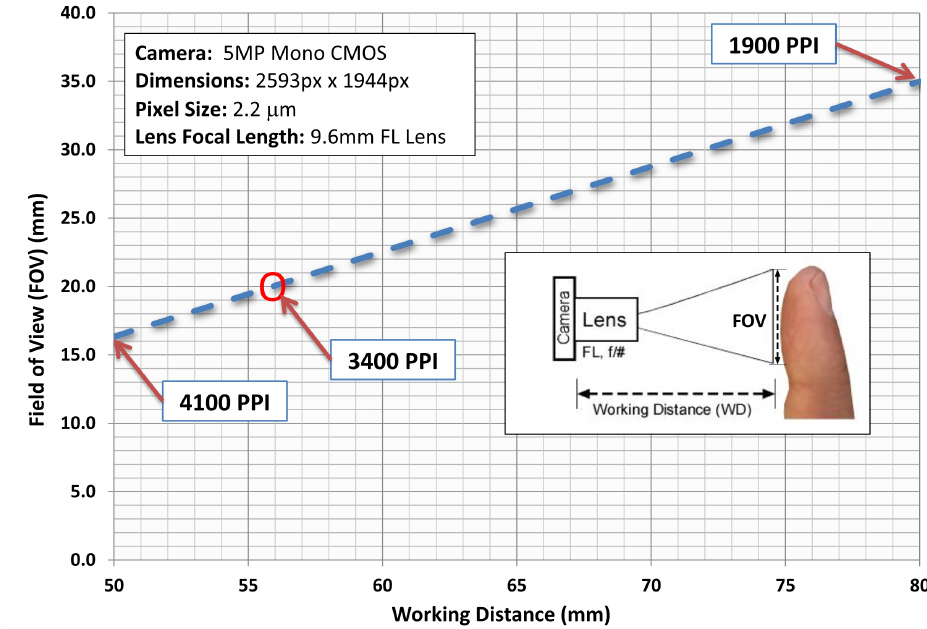
Figure 9. Trade-offs in field-of-view, working distance and resolution.